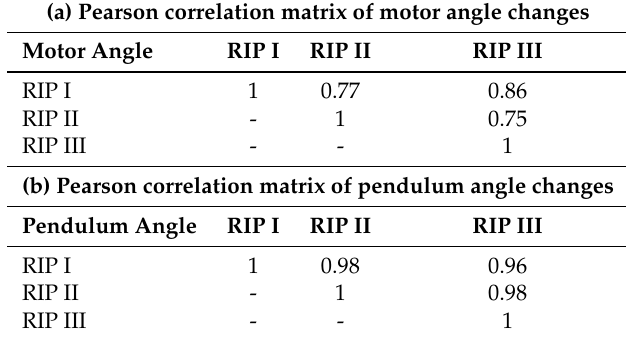
Table 2. Results of homogeneity test for dynamics of multiple IoT devices of the same type.